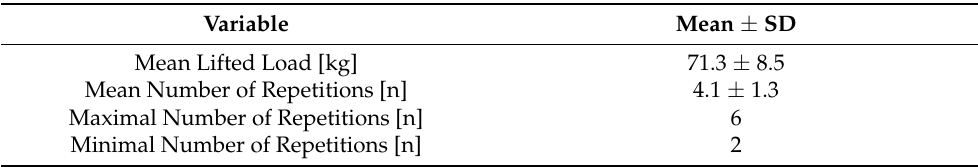
Table 1. Characteristics of the conditioning activity (back squat using 80% of one-repetition maxi- mum) in the 10% mean velocity-loss